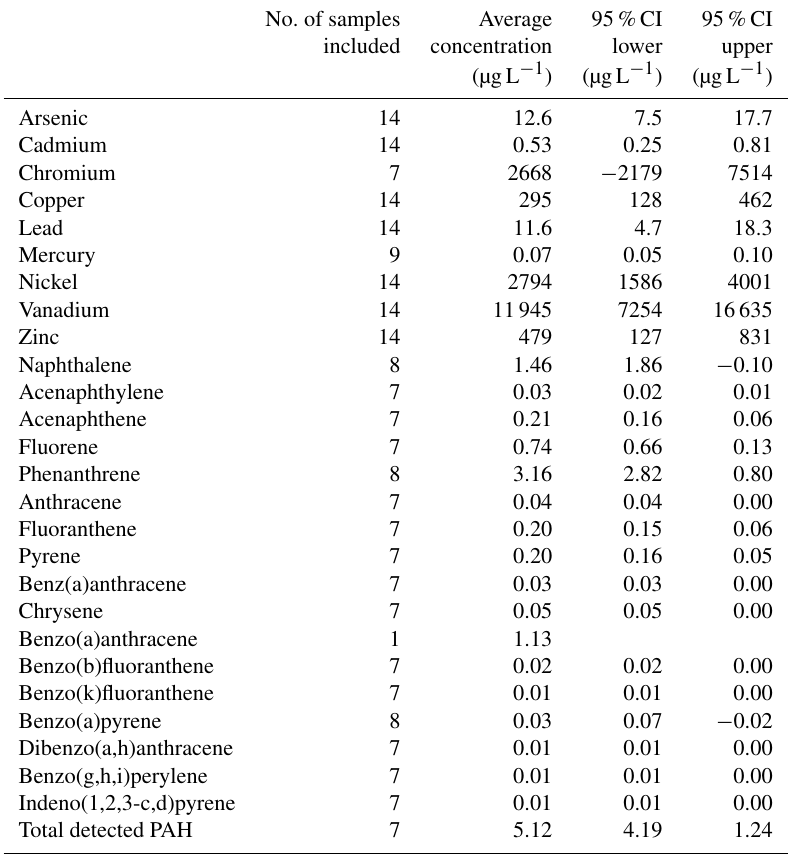
Table A3. Concentration of contaminants and nutrients in closed-loop scrubber wash water. Note that full references to sample analysis reports are given in the